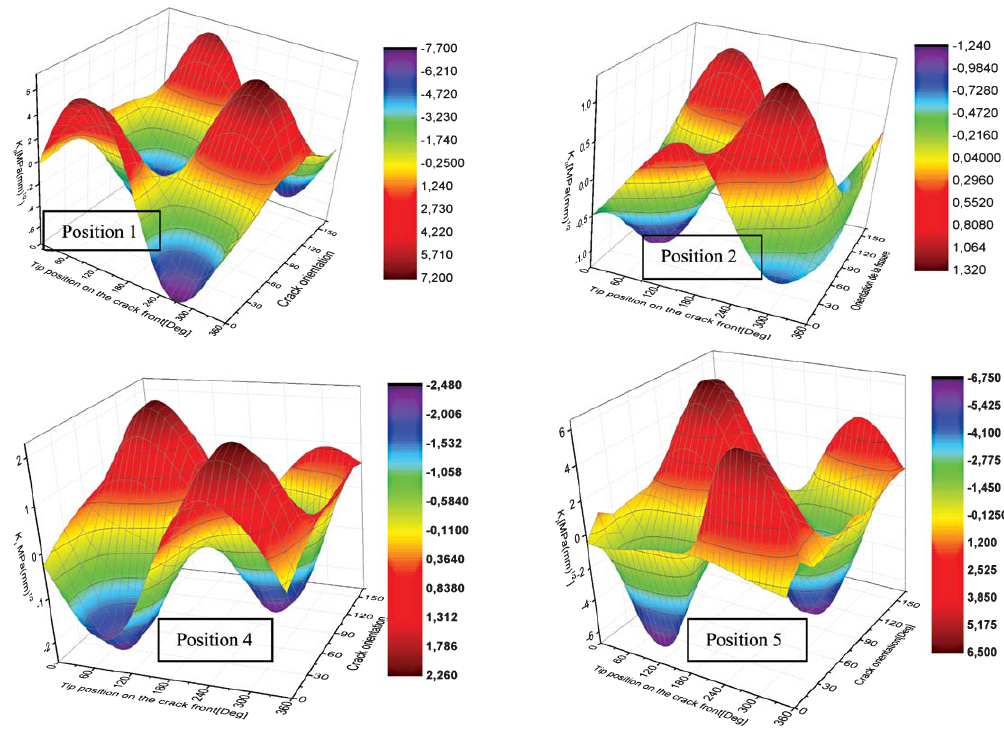
Fig. 19. K II comparison for the four locations where the crack is